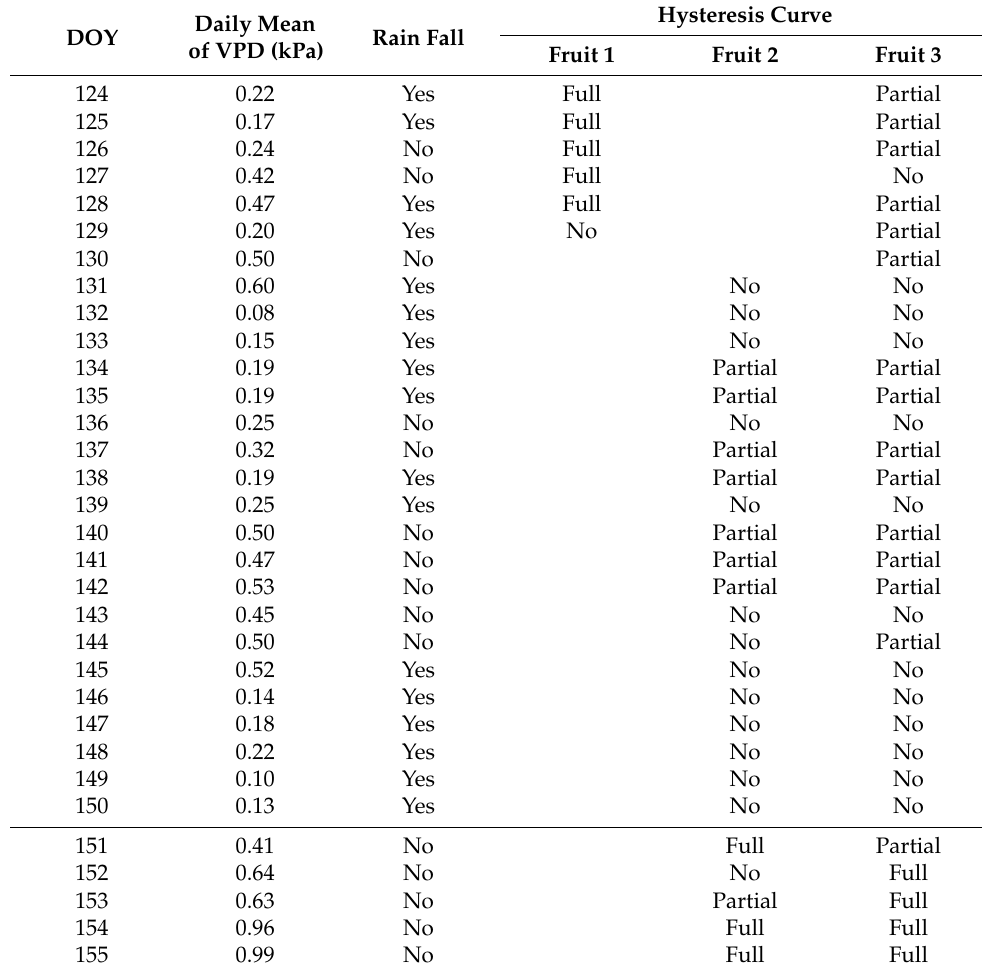
Table 1. Data of daily mean VPD and rainfall for 2019.